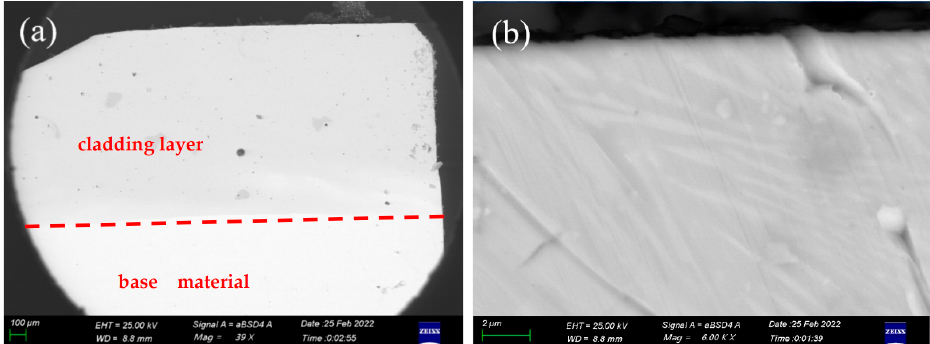
Figure 10. BSE morphology of the longitudinal section of a grinding pin with 0 wt.% Cr 3 C 2 content captured at ( a ) low power and ( b ) high power.